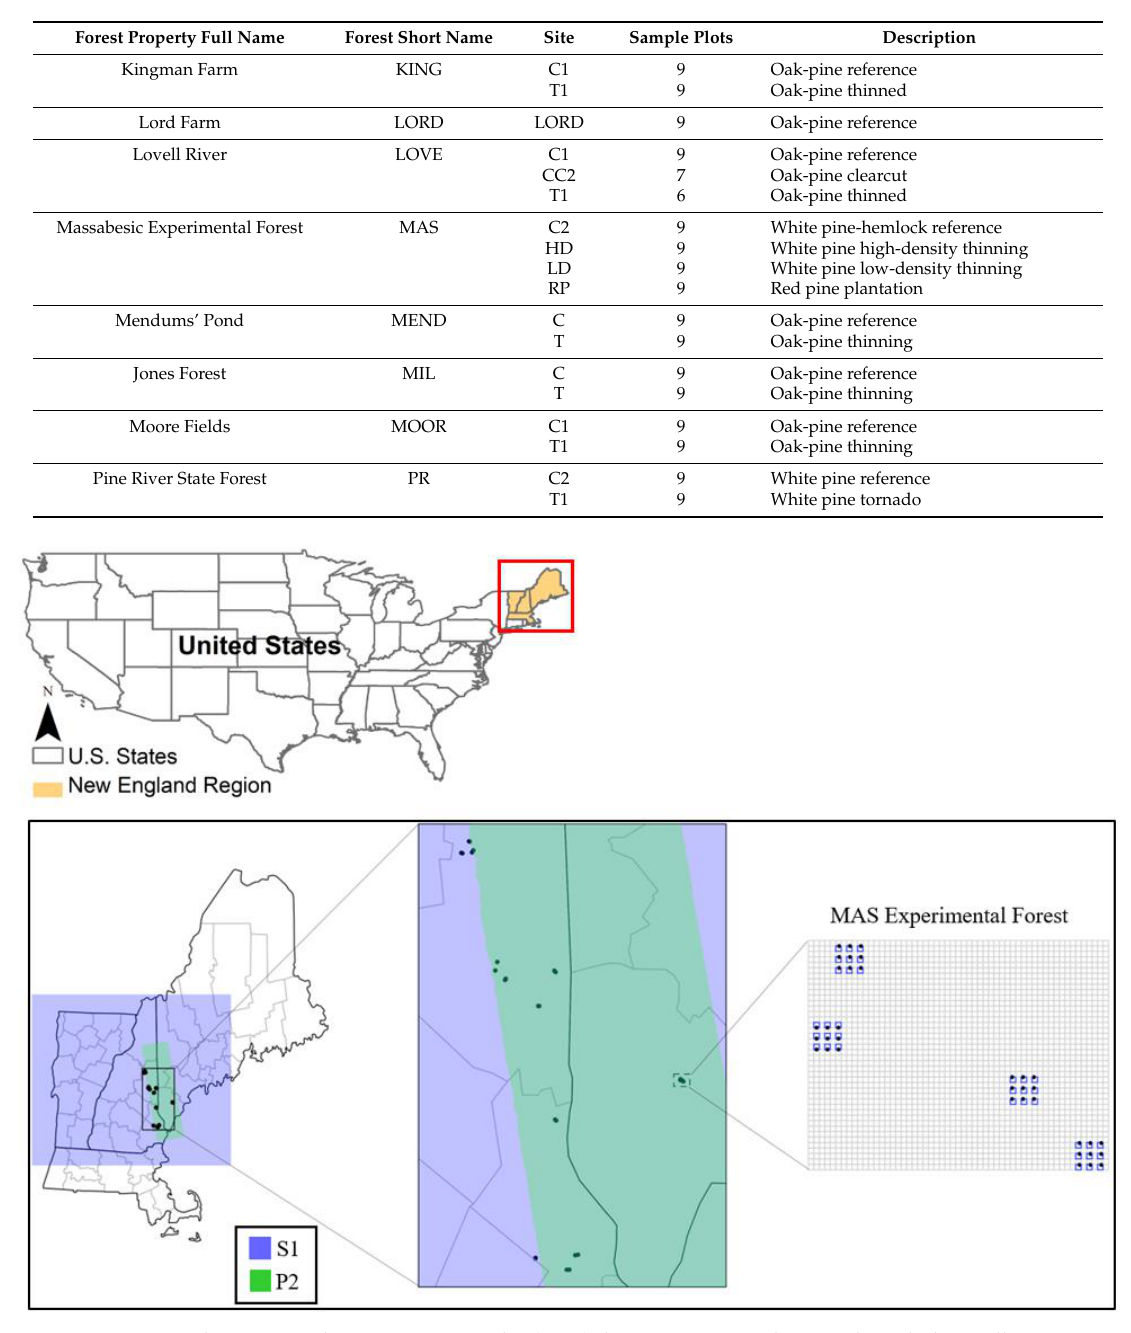
Figure 1. Study area, Synthetic Aperture Radar (SAR) data coverage, and Ground Truth data collection. S1: Sentinel-1. P2: PALSAR-2. The purple color and the green color present the coverage of the S1 and P2. The upper figure shows the geolocation of the study sites. The black dots in the two left bottom figures represent the forest. Taking the MAS forest as an example, there are four sites in this forest, and each site contains nine plots, as shown in the right bottom figure.